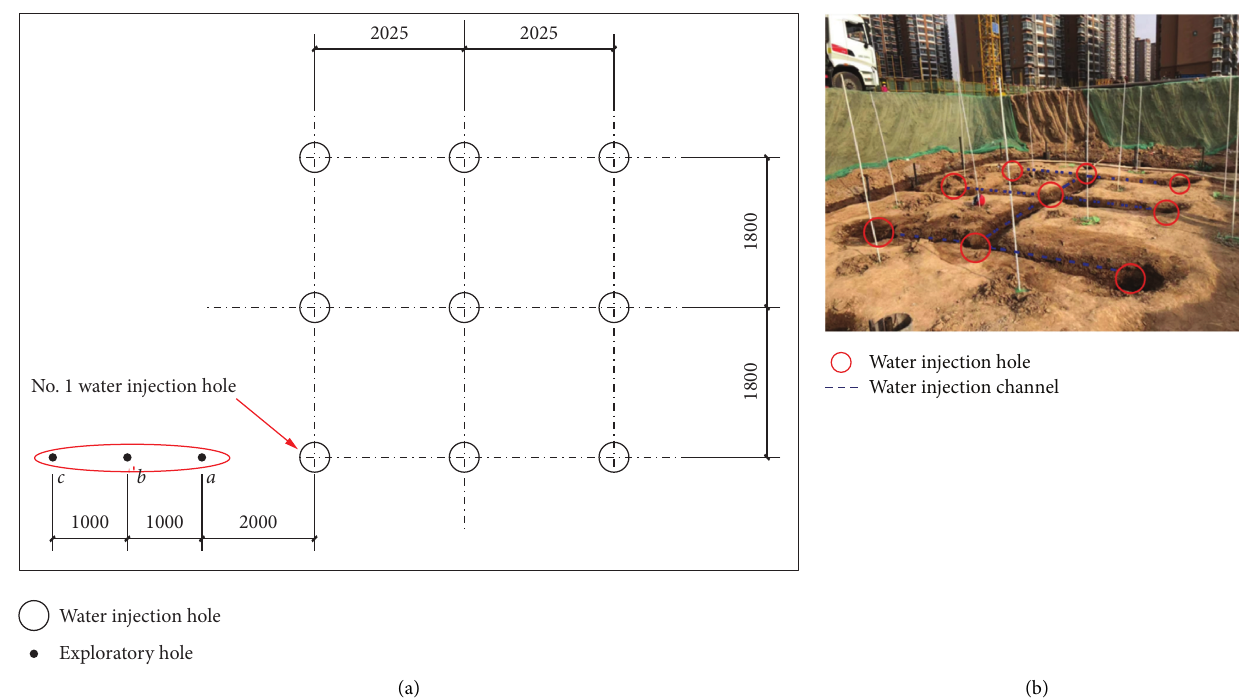
Figure 10: (a) Layout of water injection holes (unit: mm and scale: 1 :100). (b) Immersion field.